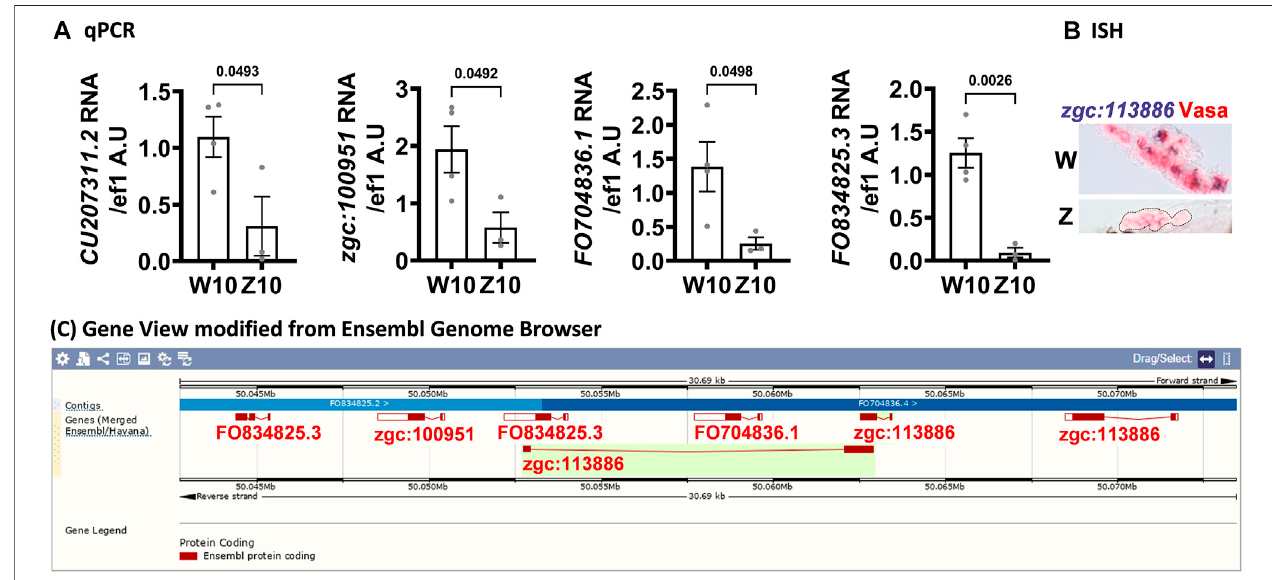
FIGURE 5 | Genes clustered on chromosome 17 are upregulated in 10-dpf germ cells of the W-hybrid. (A) . Higher expression of CU207311.2, zgc:100951, FO704836.1,FO834825.3,intheW-hybridthantheZ-hybridat10dpfasdetectedbyRT-PCR.The Y -axisistheRNAlevelinarbitraryunits(A.U.)afternormalizationwith an internal control ( ef1 ). (B) . The expression of zgc:113886 (blue-purple) is higher in the W-hybrid shown by in situ hybridization. Vasa antibody stains germ cells red in Alexa fl uor 546. (C) . All these upregulated genes are clustered in the same locus on chromosome 17 as shown by the Ensembl Gene